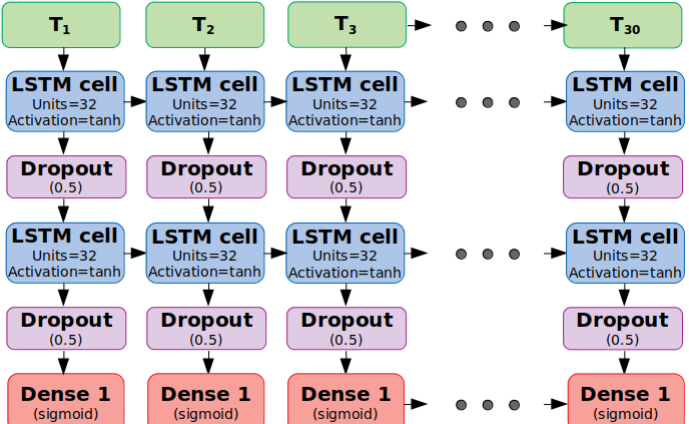
Figure 4. Architecture of the time-distributed RNN used. Green refers to the input layer, blue and purple to hidden layers, and red to the output layer. T X refers to the time-step X in the input